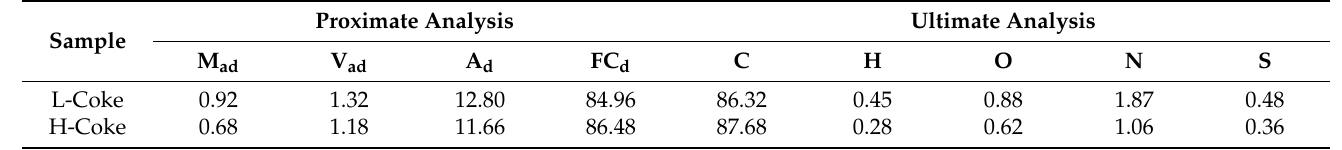
Table 1. Proximate and ultimate analysis results of metallurgical coke,